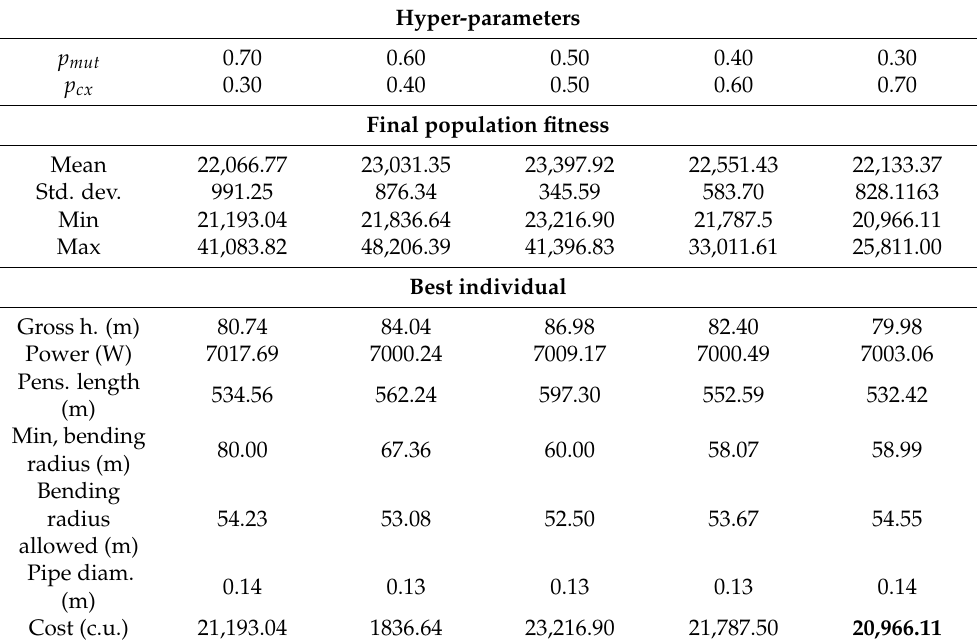
Figure 12. Evolution of the best fitness obtained through generations for the best case evaluated ( p mut = 0.30, p cx = 0.70). Table 3. Summary of the last population and best individuals obtained. Lower cost has been highlighted in